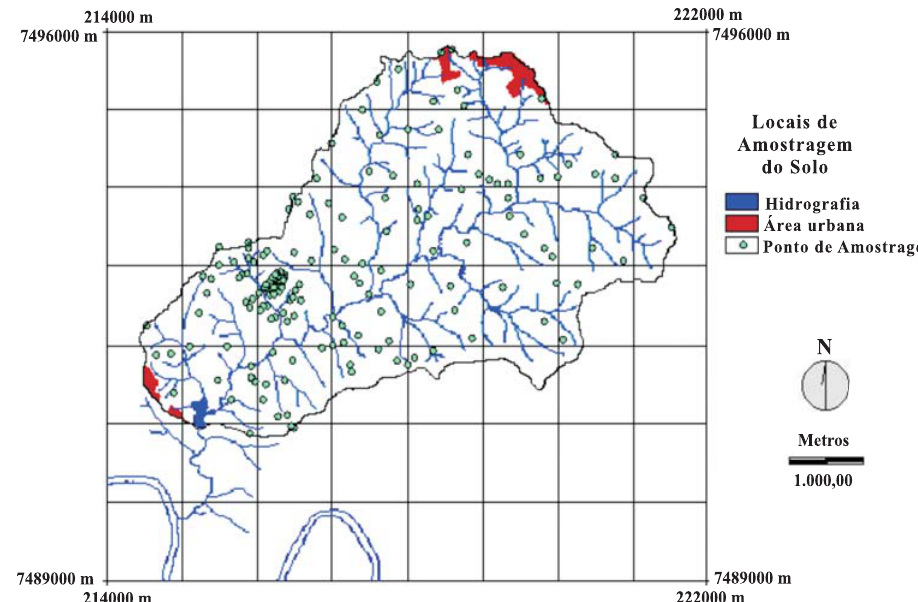
Figura 3. Locais de amostragem do solo na área de